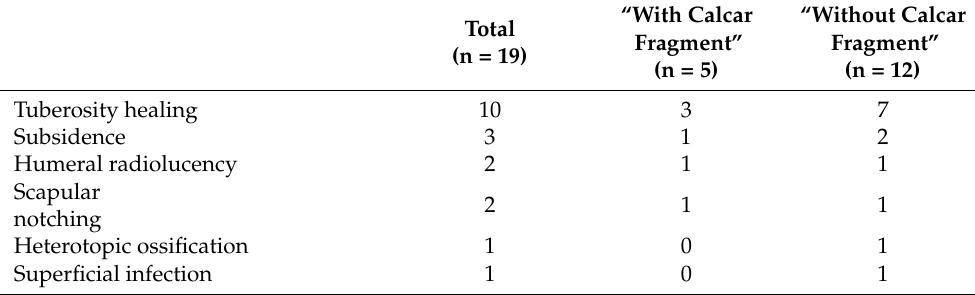
Table 3. Number and type of postoperative complications following reverse total shoulder arthro- plasty with a cementless and metaphyseal stem fixation for proximal humeral fractures “with calcar fragment” vs. “without calcar